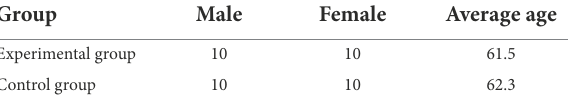
TABLE 2 Grouping of